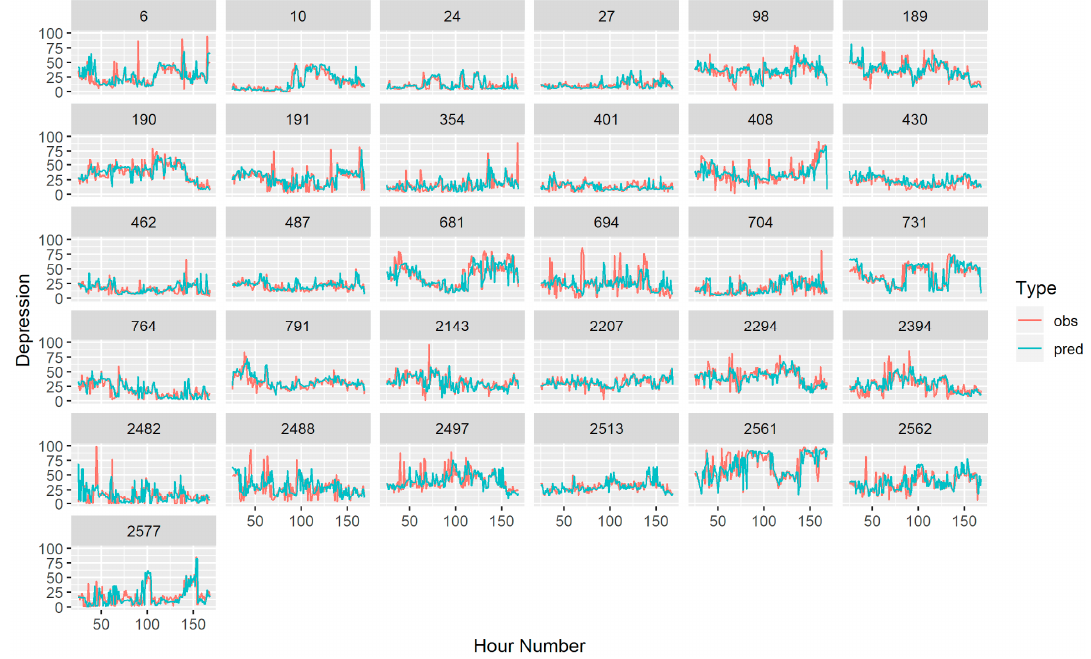
Figure 4. This plot depicts the predicted and observed values for the hourly depressed mood for the entire sample. For plotting, the average of the multiply imputed data points was computed when there was missing data.